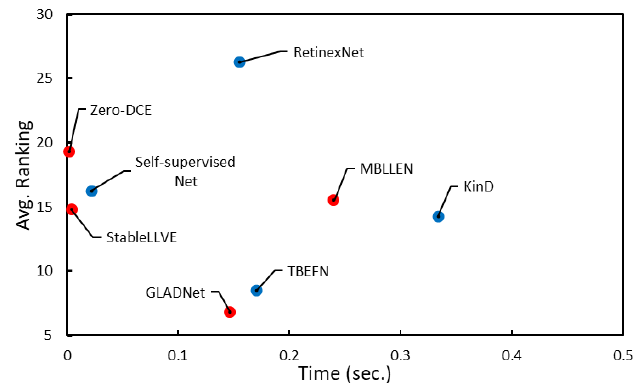
Figure 5. Avg. ranking versus Time is shown for each enhancement method. Only the methods take less than 0.5 s on GPU (NVIDIA Titan Xp GPU) to process the image of size 400 × 600 × 3 is shown in the figure. Red dots represent non-Retinex methods, while blue dots represent Retinex